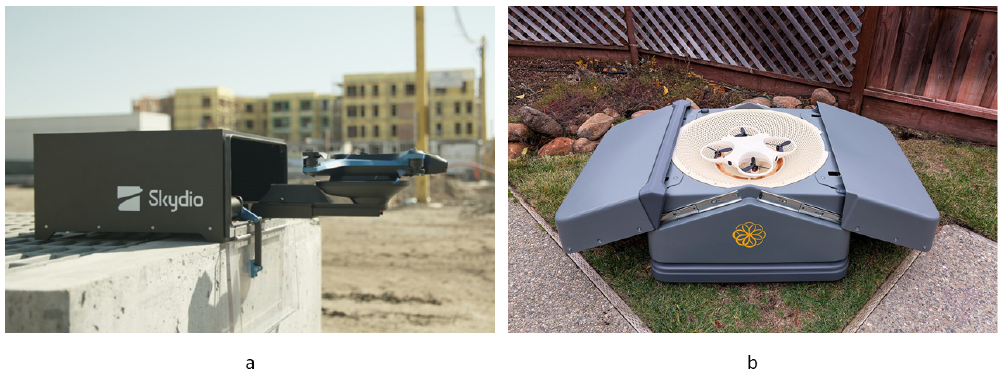
Figure 24. Examples of commercially available landing platforms with funnels for all legs ( a ) and whole UAV body ( b ) by ( a ) Skydio [69] and ( b ) Sunflower